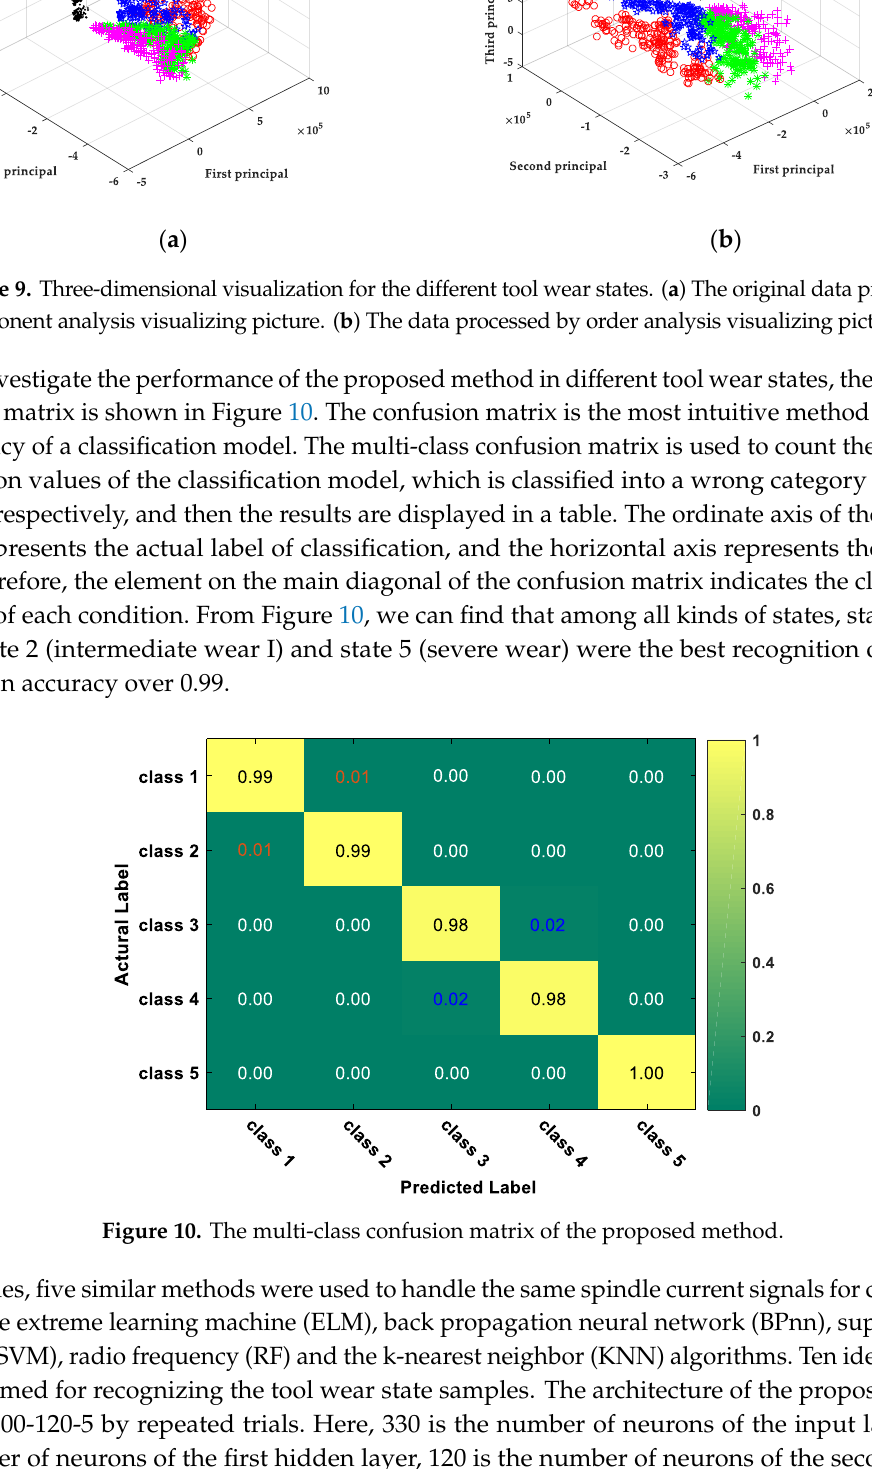
Figure 10. The multi-class confusion matrix of the proposed method.